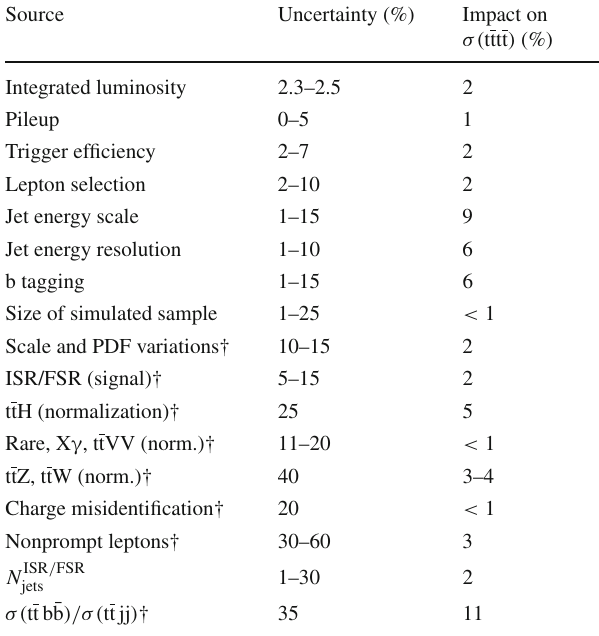
Table 2 Summary of the sources of uncertainty, their values, and their impact, defined as the relative change of the measurement of σ( tttt ) induced by one-standard-deviation variations corresponding to each uncertainty source considered separately. The first group lists experi- mentalandtheoreticaluncertaintiesinsimulatedsignalandbackground processes.Thesecondgrouplistsnormalizationuncertaintiesintheesti- mated backgrounds. Uncertainties marked (not marked) with a † in the first column are treated as fully correlated (fully uncorrelated)